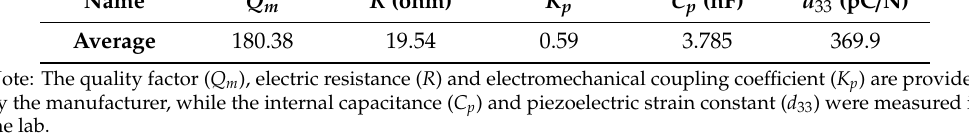
Figure 3. The structure of the piezoelectric array system. 3. Fabrication of Sensing System, Experiment and Simulation